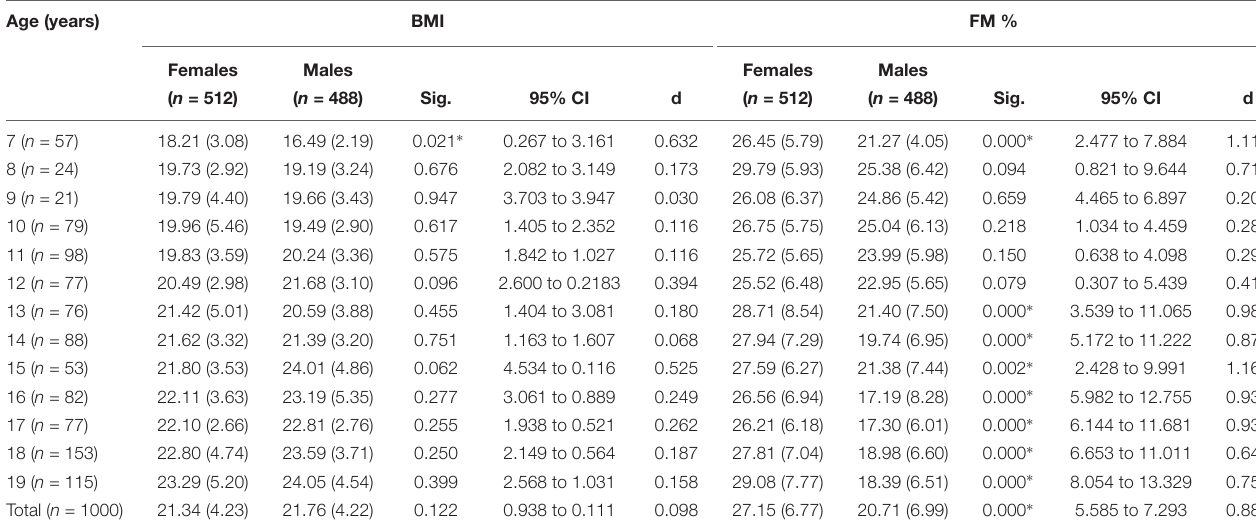
TABLE 1 | Comparison of means of BMI and FM% ( N =